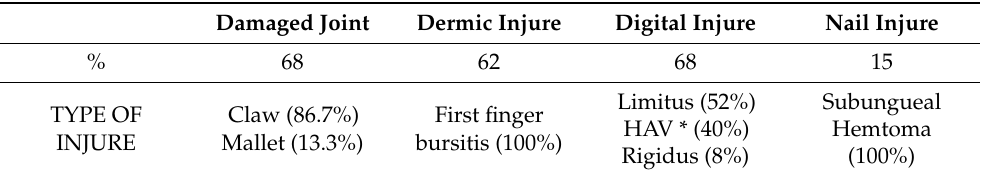
Table 2. Percentage of climber’s foot injury type. Damaged Joint Dermic Injure Digital Injure Nail Injure % 68 62 68 15 Subungueal Limitus (52%) TYPE OF Claw (86.7%) First finger Hemtoma HAV * (40%) INJURE Mallet (13.3%) bursitis (100%) (100%) Rigidus (8%)